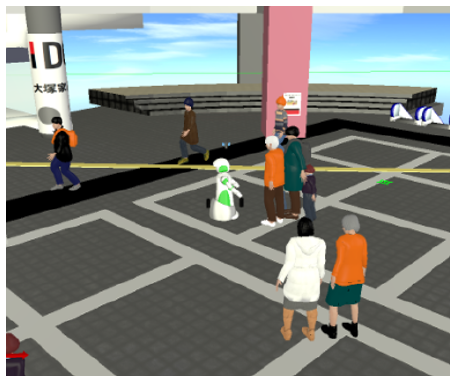
Figure 2. Using a simulator to collect artificial LiDAR measurements of people.